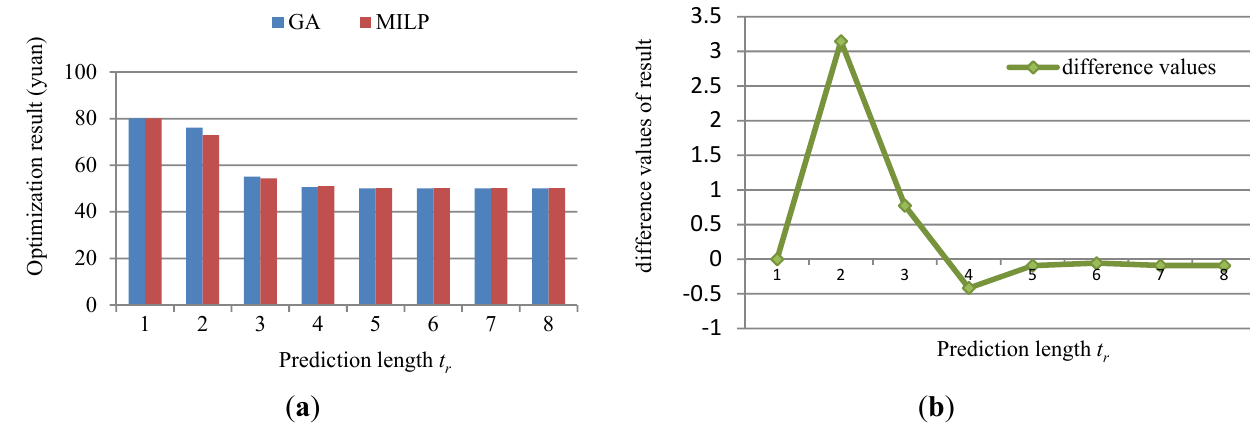
Figure 15. Comparison between the prediction-based results of different strategies: ( a ) The results of GA and MILP based on prediction; ( b ) The difference values of the prediction-based results of GA and MILP.